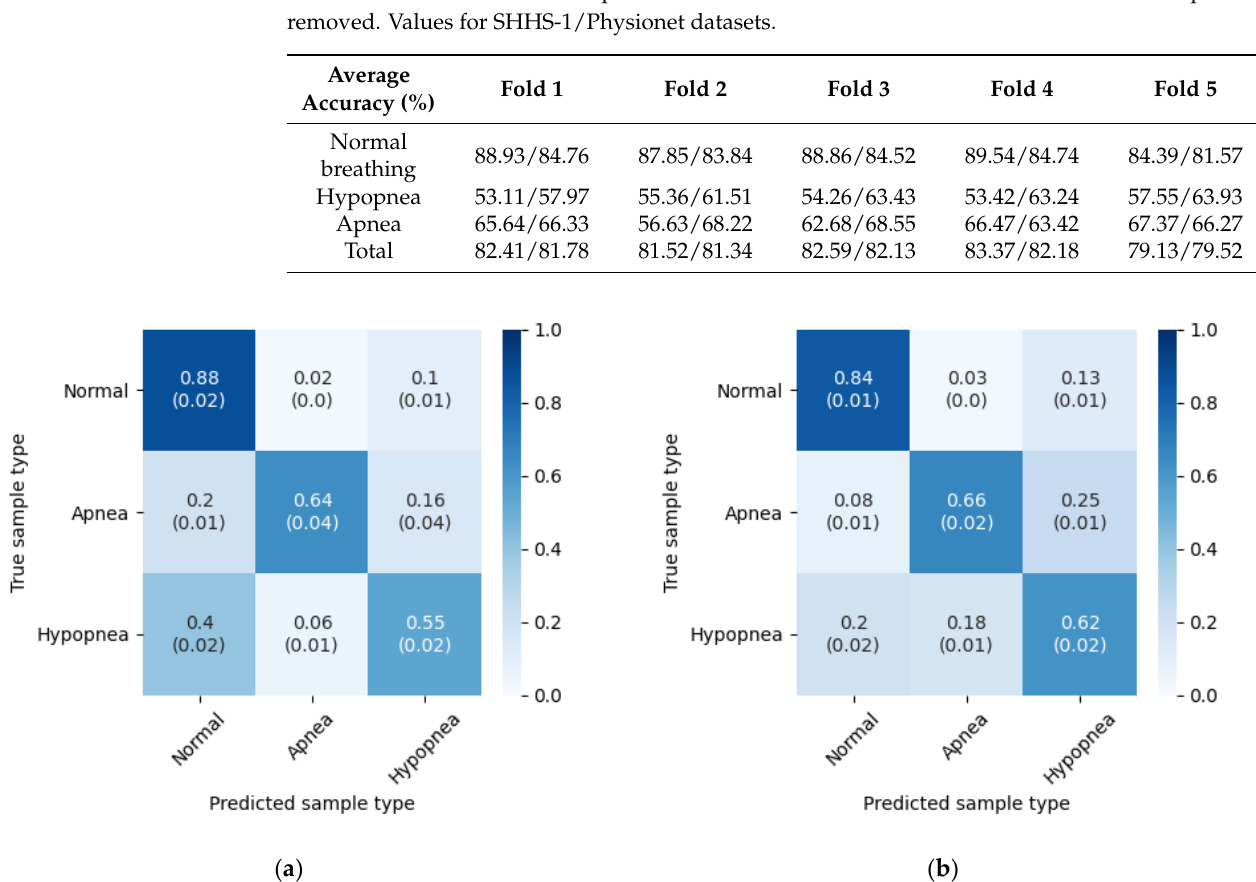
Figure 10. Three-class inference confusion matrix, mean and standard deviation from 5 experiment iterations. “Wake” periods removed. Values are row-normalized and rounded to two decimal places. ( a ) Test set from SHHS-1 database; ( b ) PhysioNet Sleep Database.